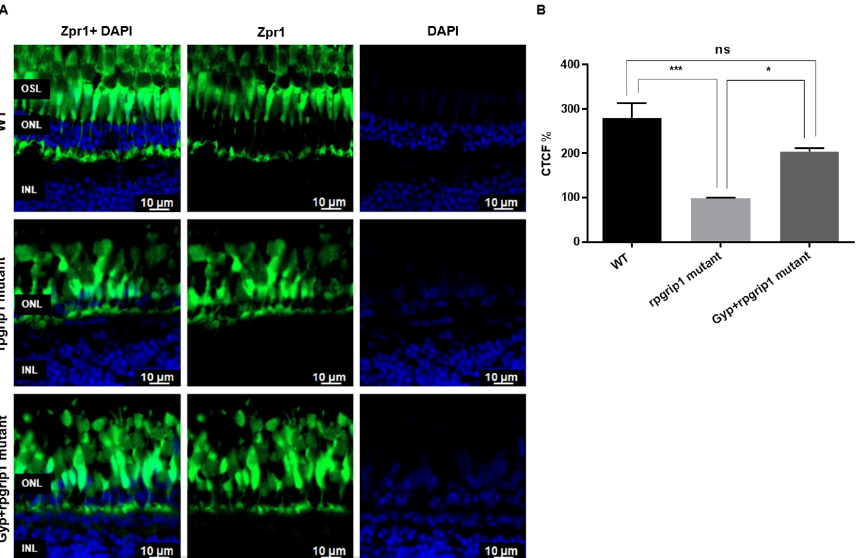
Figure 2. The effect of Gyp treatment on cone degeneration. ( A ) Immunostaining of retinal sections of wildtype, rpgrip1 mutant and Gyp-treated rpgrip1 mutant zebrafish at 6 mpf using zpr-1 antibody where zpr1 stained the cones in green and DAPI labelled nuclei in blue. ( B ) Intensity fluorescence signals (the corrected total cell fluorescence, CTCF) were measured using ImageJ. Statistical compar- isons between individual groups were carried out using one-way ANOVA followed by Bonferroni’s test. Data are displayed as mean ± SEM ( n = 5 animals of each group). Ns, no significance; * p < 0.05, *** p < 0.001. INL, inner nuclear layer; ONL, outer nuclear